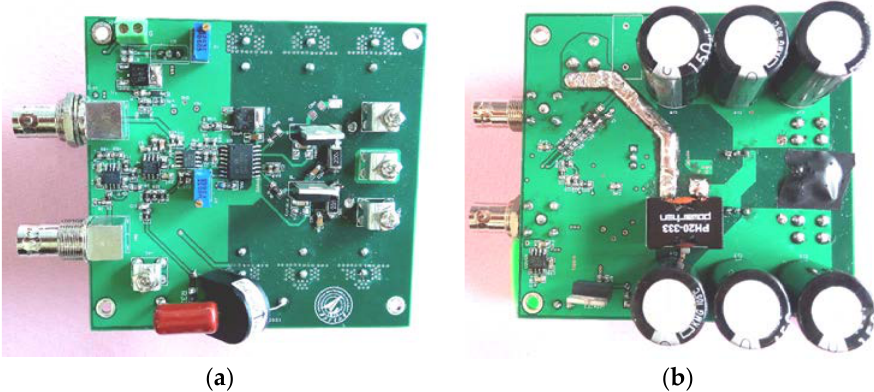
Figure 5. Circuit realization of FFDISM controller with i CA feedback (CNRL2).